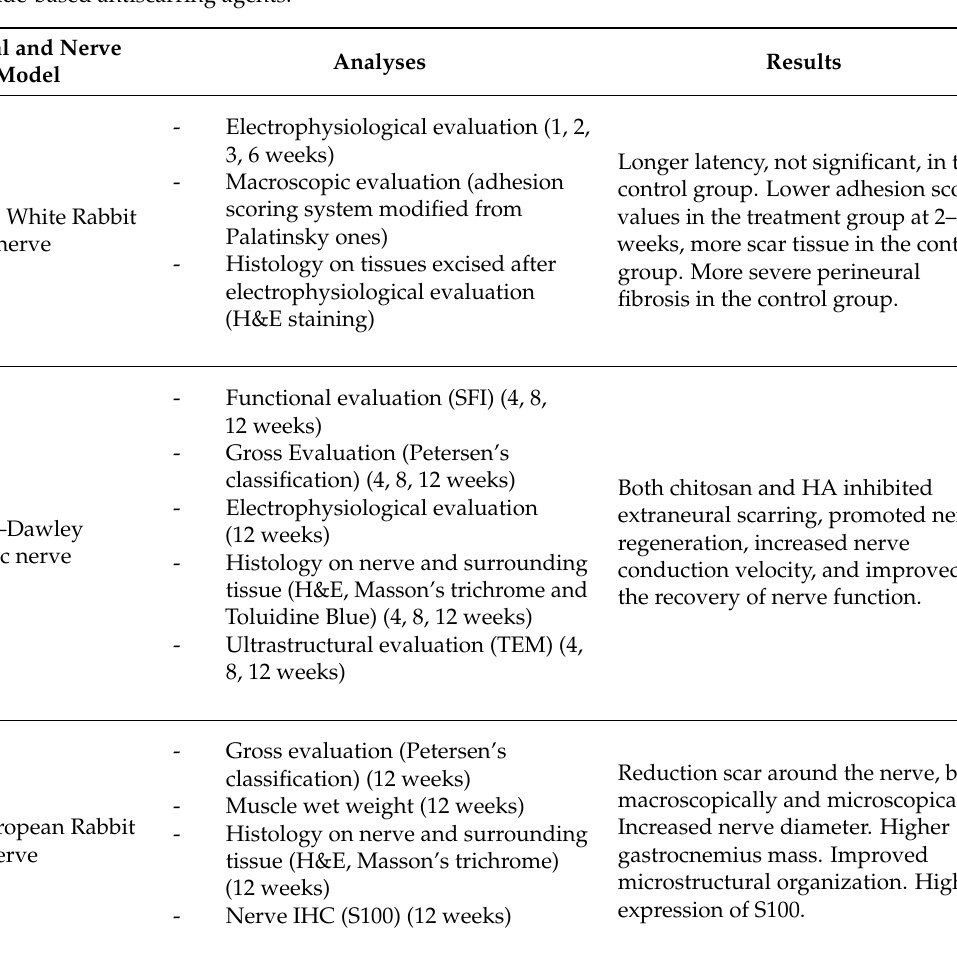
Table 2. Polysaccharide-based antiscarring